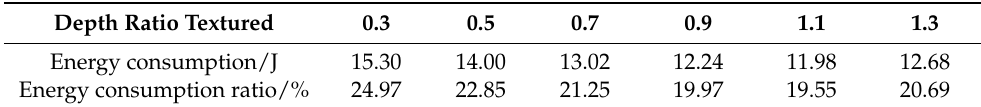
Table 3. Energy consumption and its ratio in one cycle with different depth ratio textured when area ratio textured is 0.4.